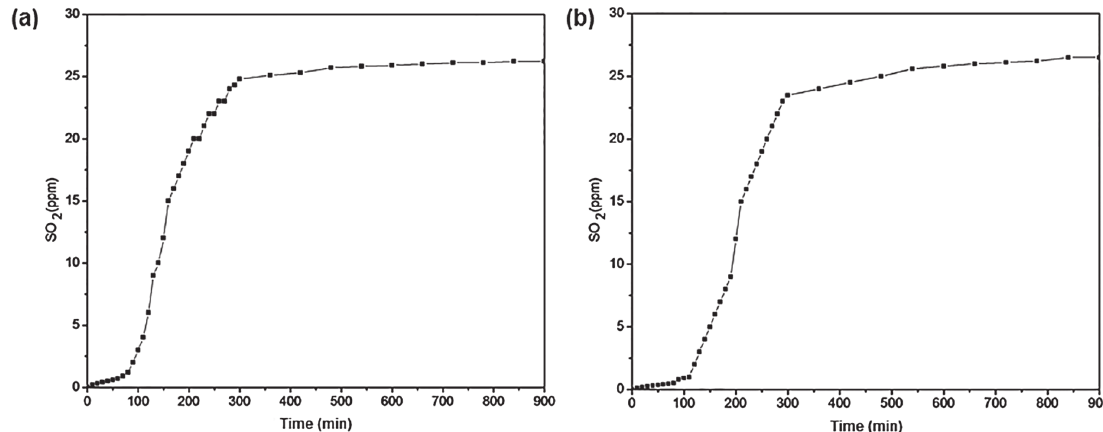
Figure 6 - Evolution of SO